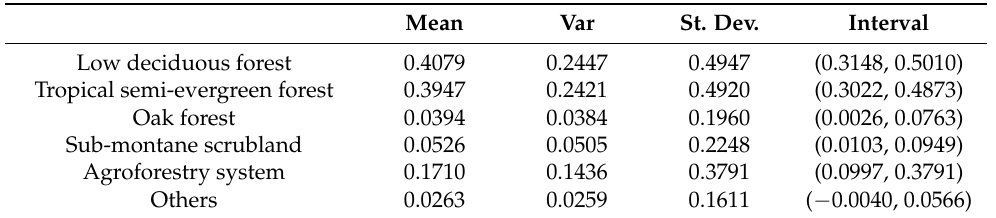
Table 6. Shannon–Wiener Biodiversity Index ( SWI ) statistics by